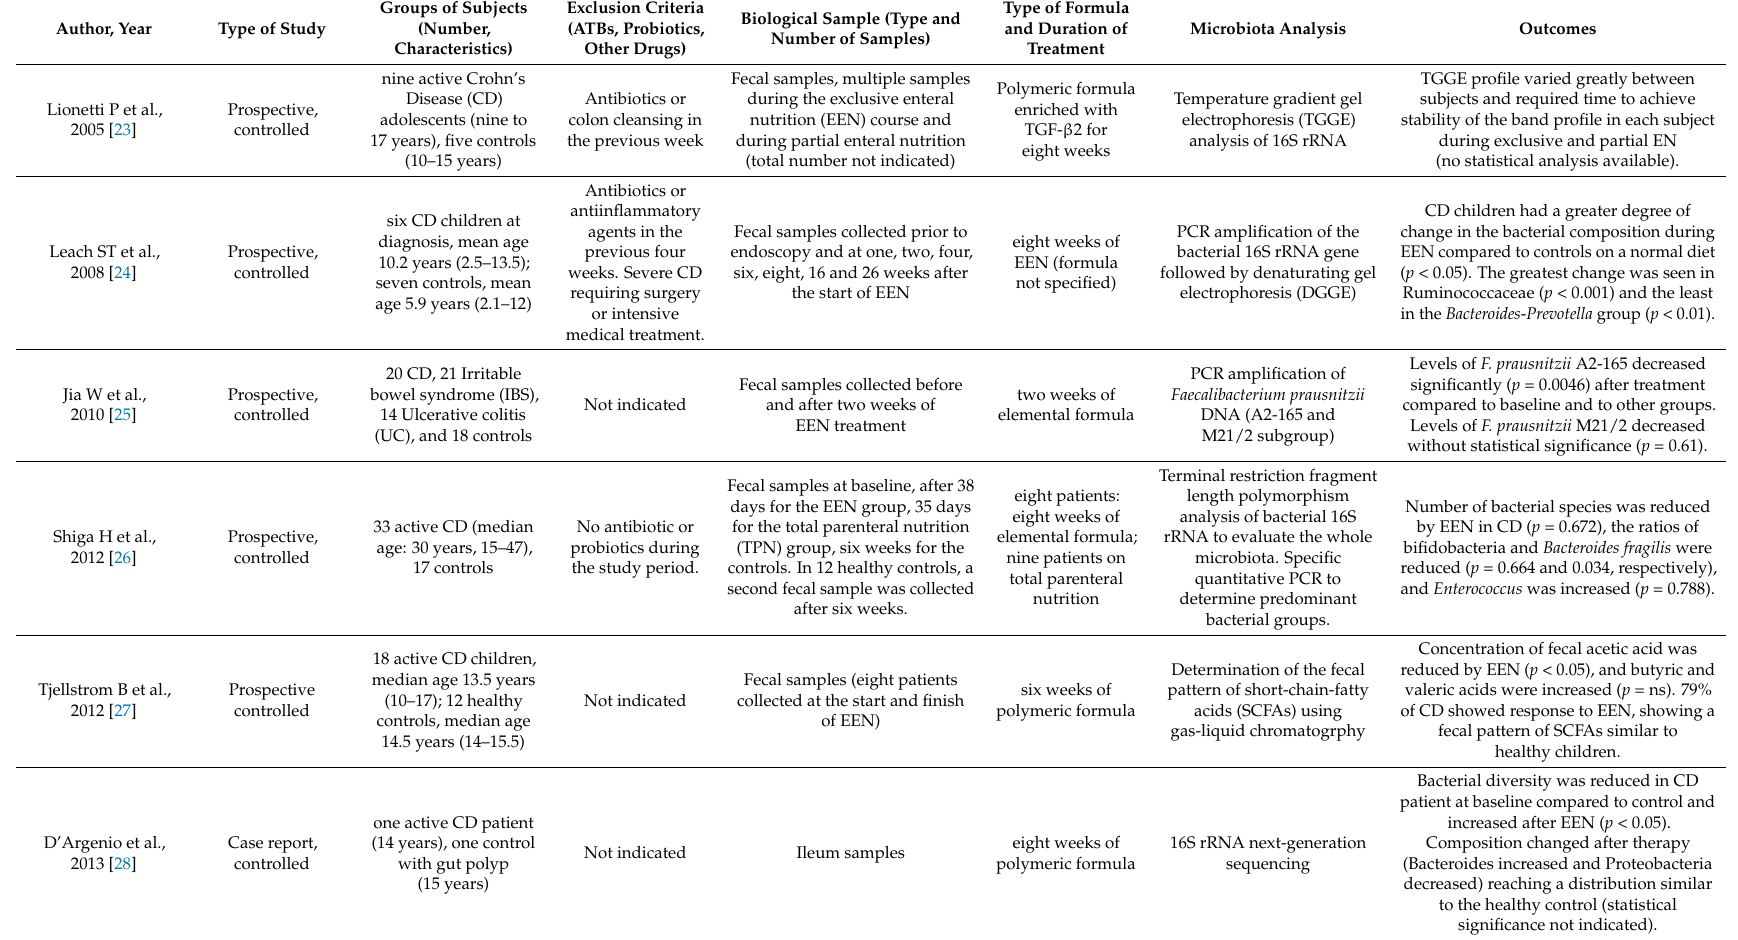
Table 1. Characteristics and main outcomes of the 14 studies included in the